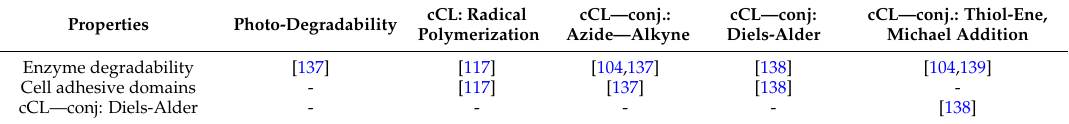
Table 1. Combinations of functional properties realized in peptide-based macromers as discussed in this review. cCL stands for chemical cross-linking and conj. illustrates that the corresponding functional groups allow for cross-linking via conjugation